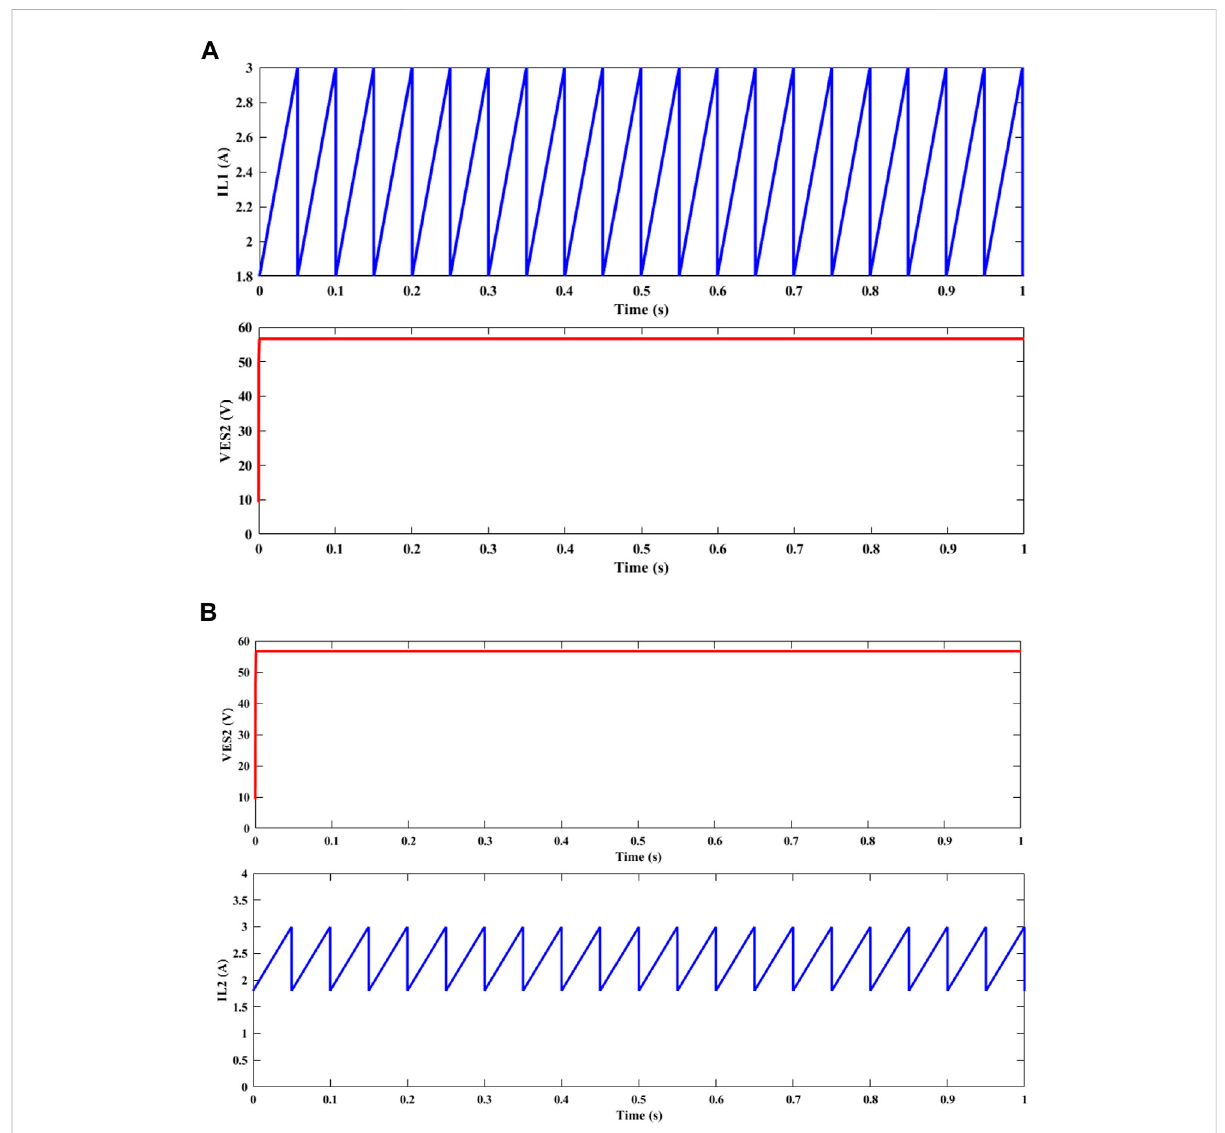
level. Figure 10B represents a real-time DSP fl owchart used to